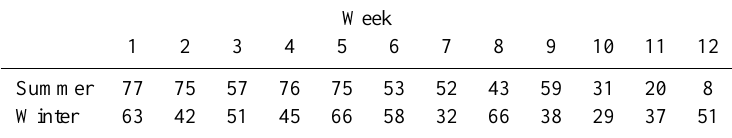
Table 4. Percentage of basin area covered weekly by surface temperature data used in the ST and STT7 sampling strategies. Numbers represent the percentage ratio between the number of 1 / 2 ◦ × 1 / 2 ◦ gridpoints with surface temperature observations and the total number of